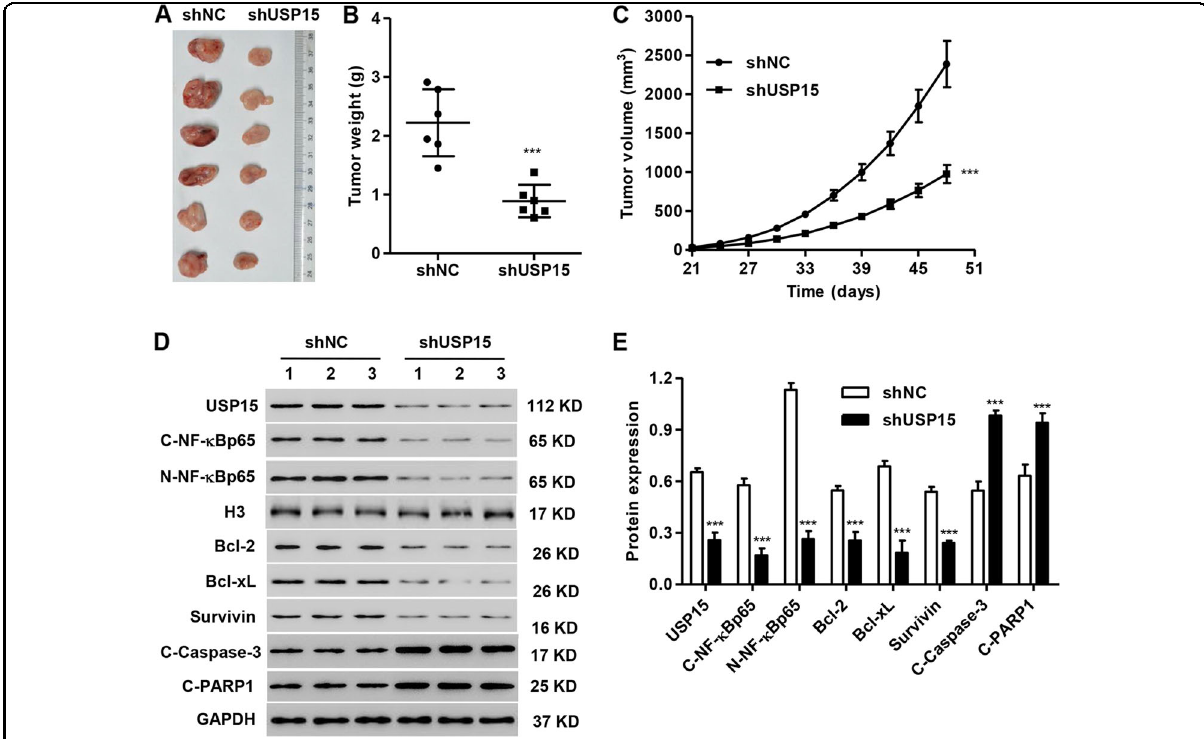
Fig. 5 USP15 knockdown inhibits tumor growth and related protein expression in MM in vivo. After RPMI 8226 cells were transfected with pLKO.1-USP15-shRNA or the negative control (shNC) and injected into the nude mouse xenograft model, the mice were sacri fi ced 48 days later, the tumor weight ( a , b ) and volume ( c ) were evaluated, and the expression of USP15, Bcl-2, Bcl-xL, Survivin, cleaved Caspase-3 (C-Caspase-3), cleaved PARP1 (C-PARP1), nuclear NF- κ Bp65, and cytoplasmic NF- κ Bp65 in xenograft tumors was measured by western blot ( d , e ). *** P < 0.001 compared with